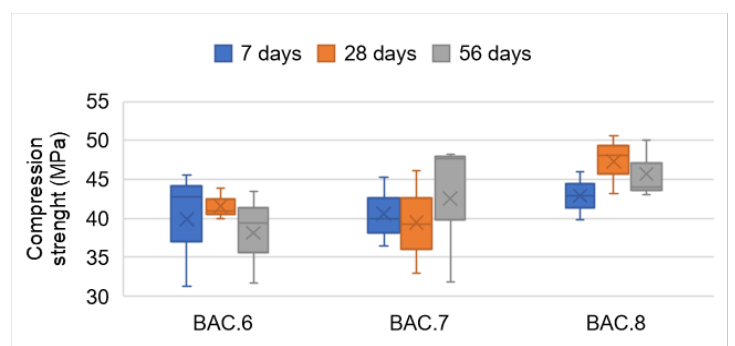
Figure 6 – Compression resistance results at 7 days, 28 days and 56